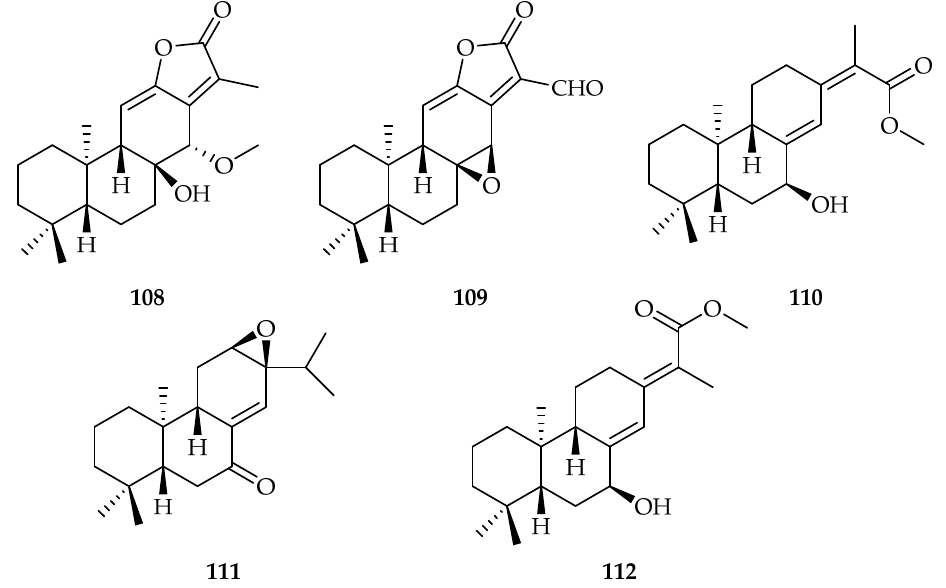
Figure 45. Structures of euphonoids A−D 108–111 [68] and fischeriabietane A 112 [68,69]. Fischerianoids A–C were also isolated and identified from the ethyl acetate extracts of roots of Euphorbia fischeriana (Euphorbiaceae). Fischerianoid A 113 , and fischerianoid B with IC 50 values of 12.10 and 15.95 μM for compound 113 , respectively, with 9.12 and 8.50 μM, respectively, for compound 114 . Cisplatin was used as the positive control, and no obvious cytotoxicity was observed for the normal cell NCM460 [70] (Figure 46).